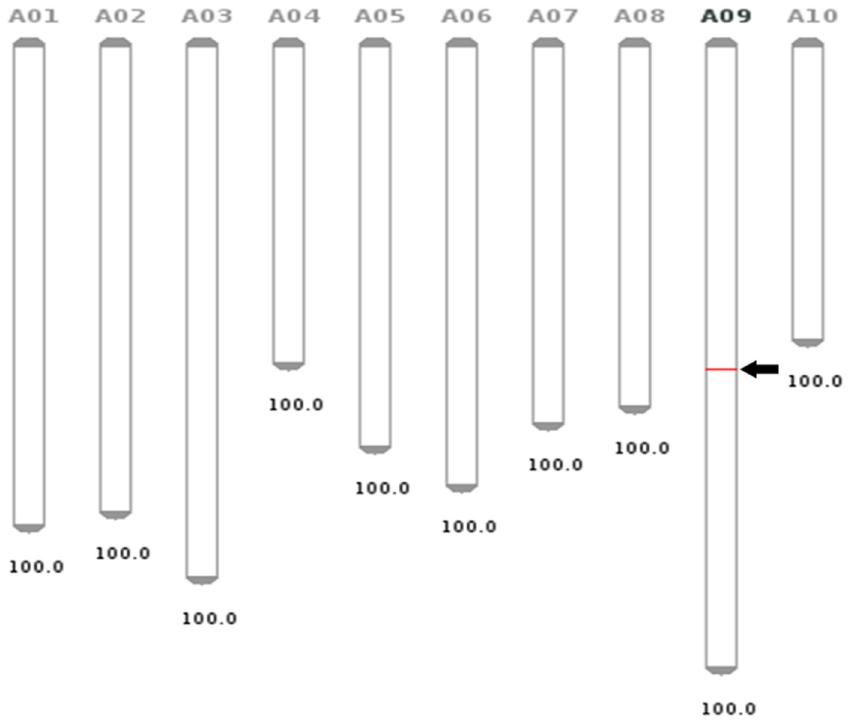
Figure 3. Detection of T-DNA insertion site in IGA7 by FSTVAL analysis. Insertion position (red bar indicated by arrow) in chromosome of the IGA7 was intergenic region on chromosome 9. Each number under the chromosome means the drawing scale (kb/px). The analysis suggested that the T-DNA was located 4.286 kb upstream of the Bra028059 gene that encodes an N-terminal-domain- containing essential protein Yae1 on chromosome 9.